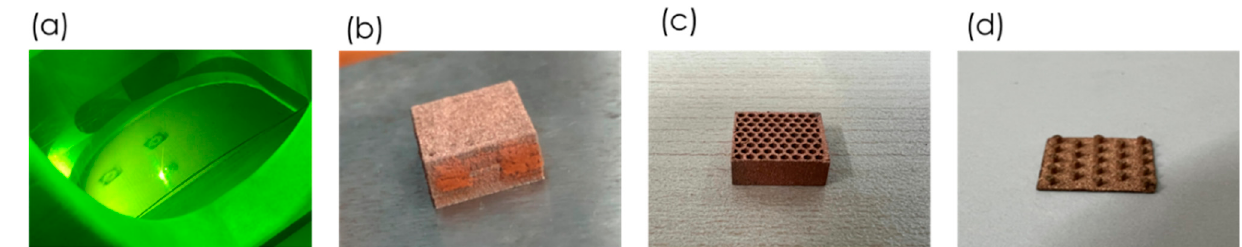
Figure 13. ( a ) 3D printing microchannel, ( b ) double-layer reflux microchannel l, ( c ) honeycomb microchannel, ( d ) pin-wing microchannel.